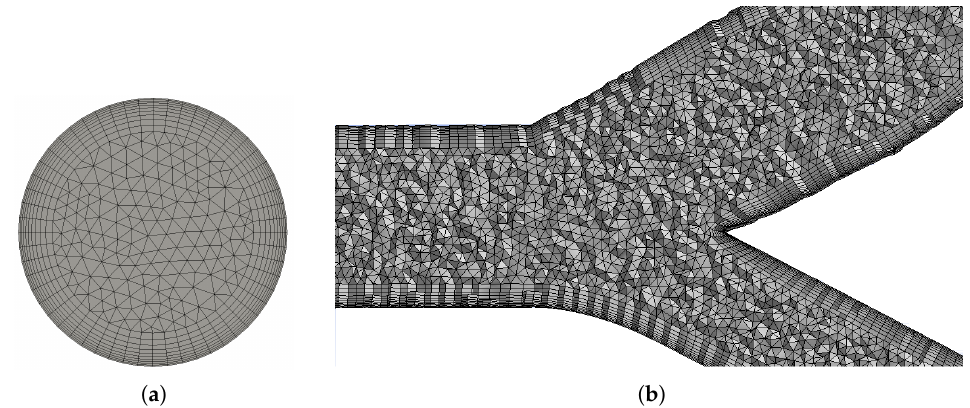
Figure 3. Computational mesh at the ( a ) inlet, and ( b ) inside of the carotid